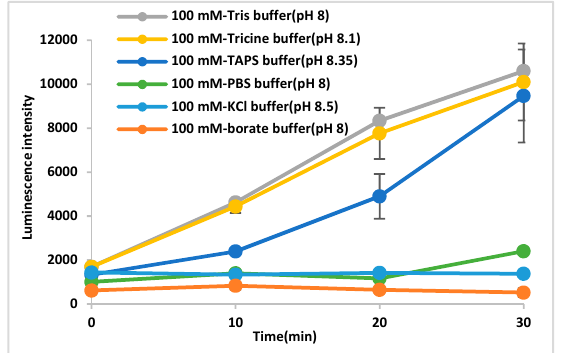
Figure 3. Luminescence from AuNP (15 nm) dispersed in various